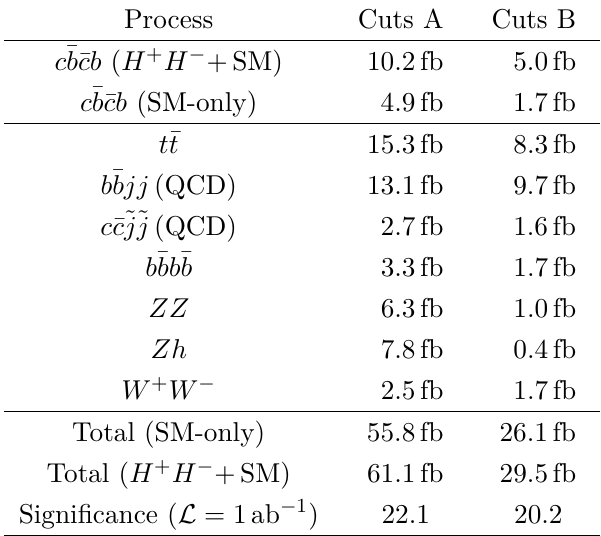
the charged Higgs mass, one needs to identify the correct bottom and charm pairing, to which we turn to